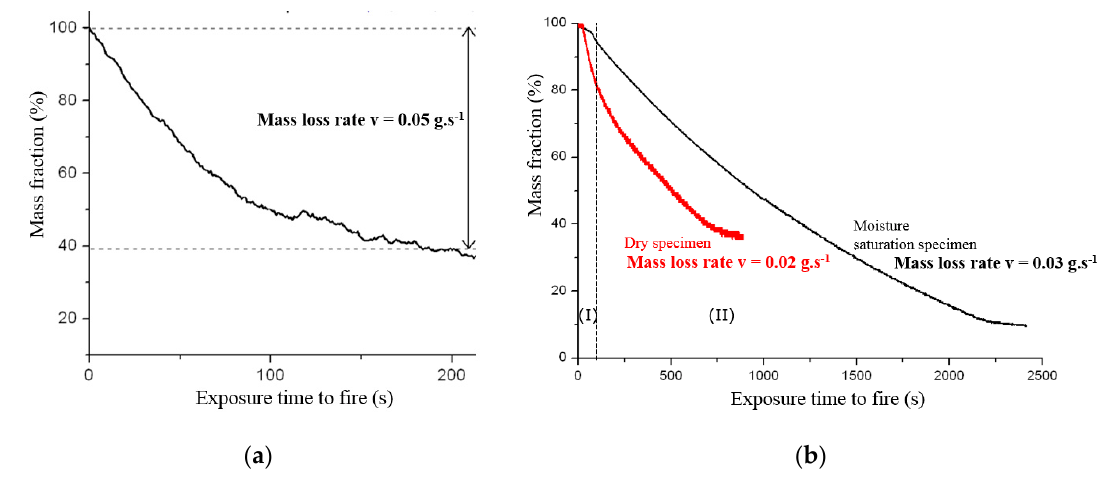
Figure 5. Mass loss curves as a function of fire exposure time for dry E-glass polyester single skin ( a ) and sandwich composite beam ( b ) from cone calorimetry measurements at 750 °C.